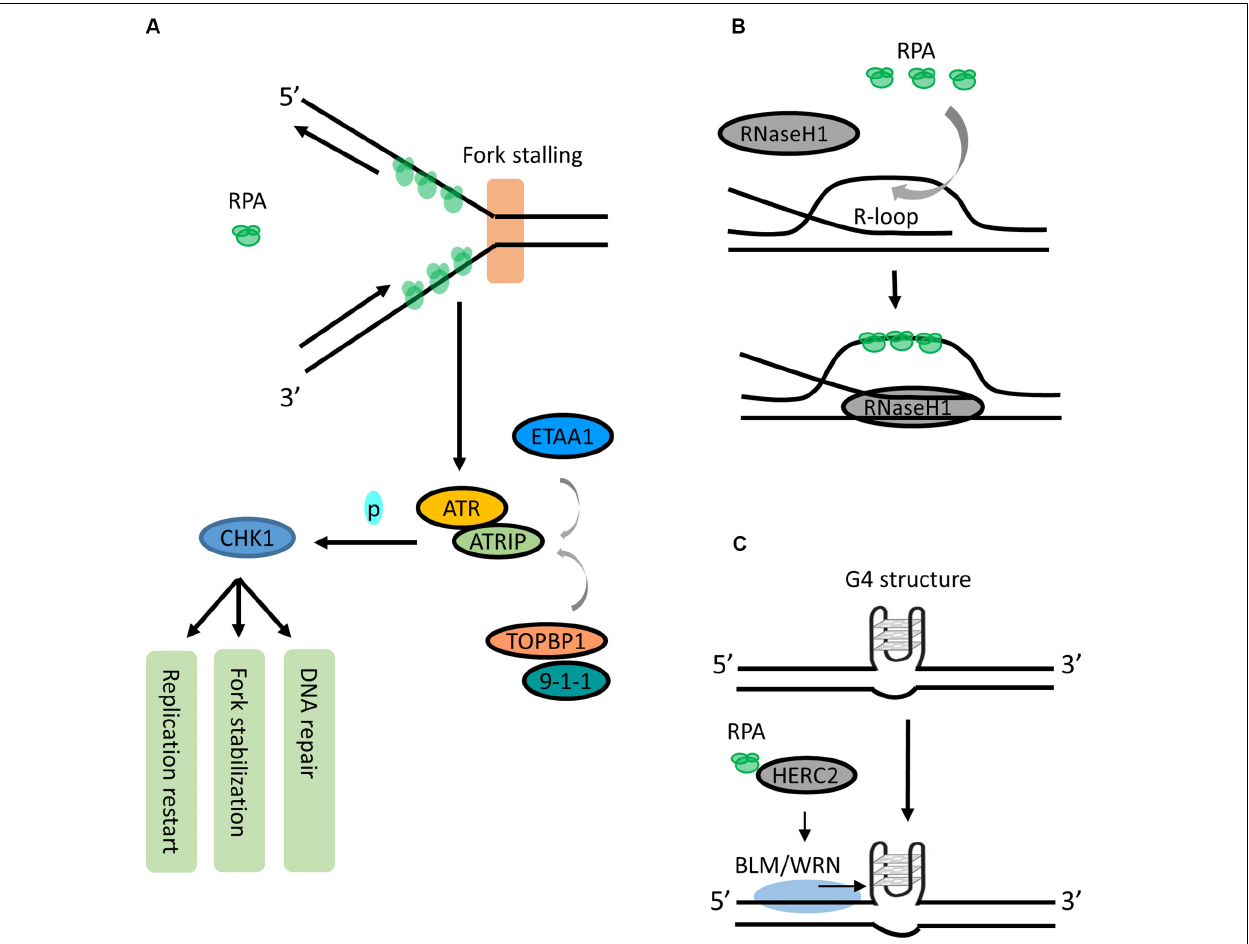
FIGURE 2 | Roles of RPA in RS responses. (A) RPA is a signal responder of RS in ATR signaling. During RS response, the RPA-coated ssDNA acts as a key recruitment/activation platform for recruiting ATR-ATRIP to the stalled fork. The kinase activity of ATR-ATRIP is stimulated by TOPBP1:9-1-1 or ETAA1. Activated ATR-ATRIP phosphorylates and activates CHK1, which induces cell cycle arrest to allow DNA repair, fork stabilization or replication start. (B) RPA is a sensor for resolving R-loops. RPA may sense the increase of R-loops as an RS signal and promotes RNaseH1 resolving R-loops by recognizing ssDNA within R-loop. (C) RPA can unfold the G4 structures. RPA interacts with HERC2 and promotes BLM/WRN helicase to unwind or suppress G4